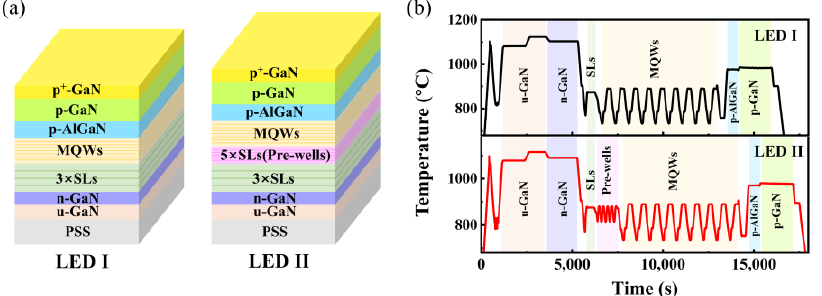
Figure 1. ( a ) Schematic diagram of the epitaxial structure of LED I and LED II. ( b ) Temperature profile during the growth process of LED I and LED